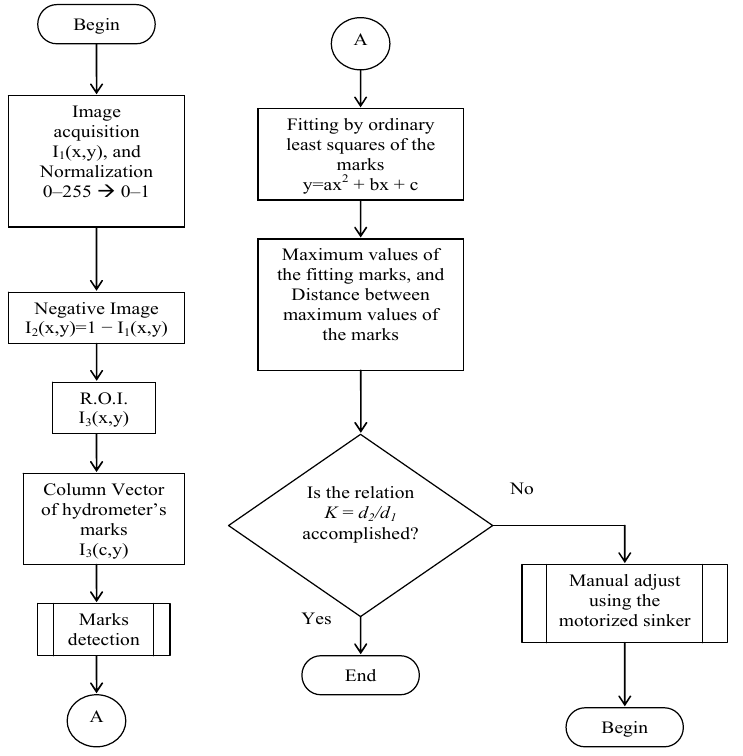
Figure 4. Image processing algorithm